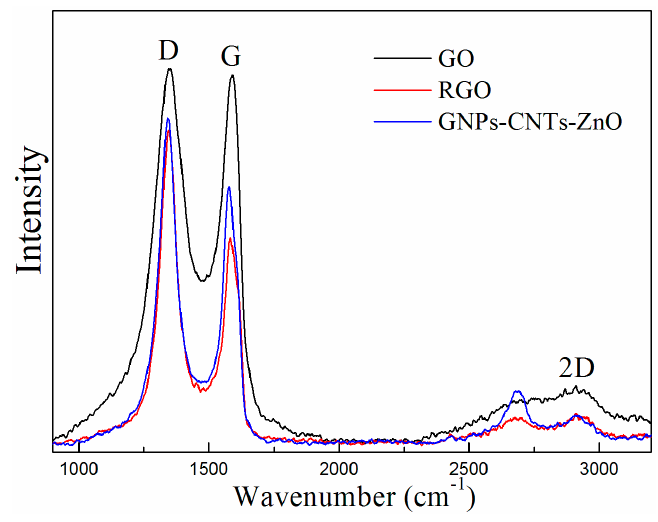
Figure 5. Raman spectrums of GO, RGO, and GNPs-CNTs-ZnO hybrid.